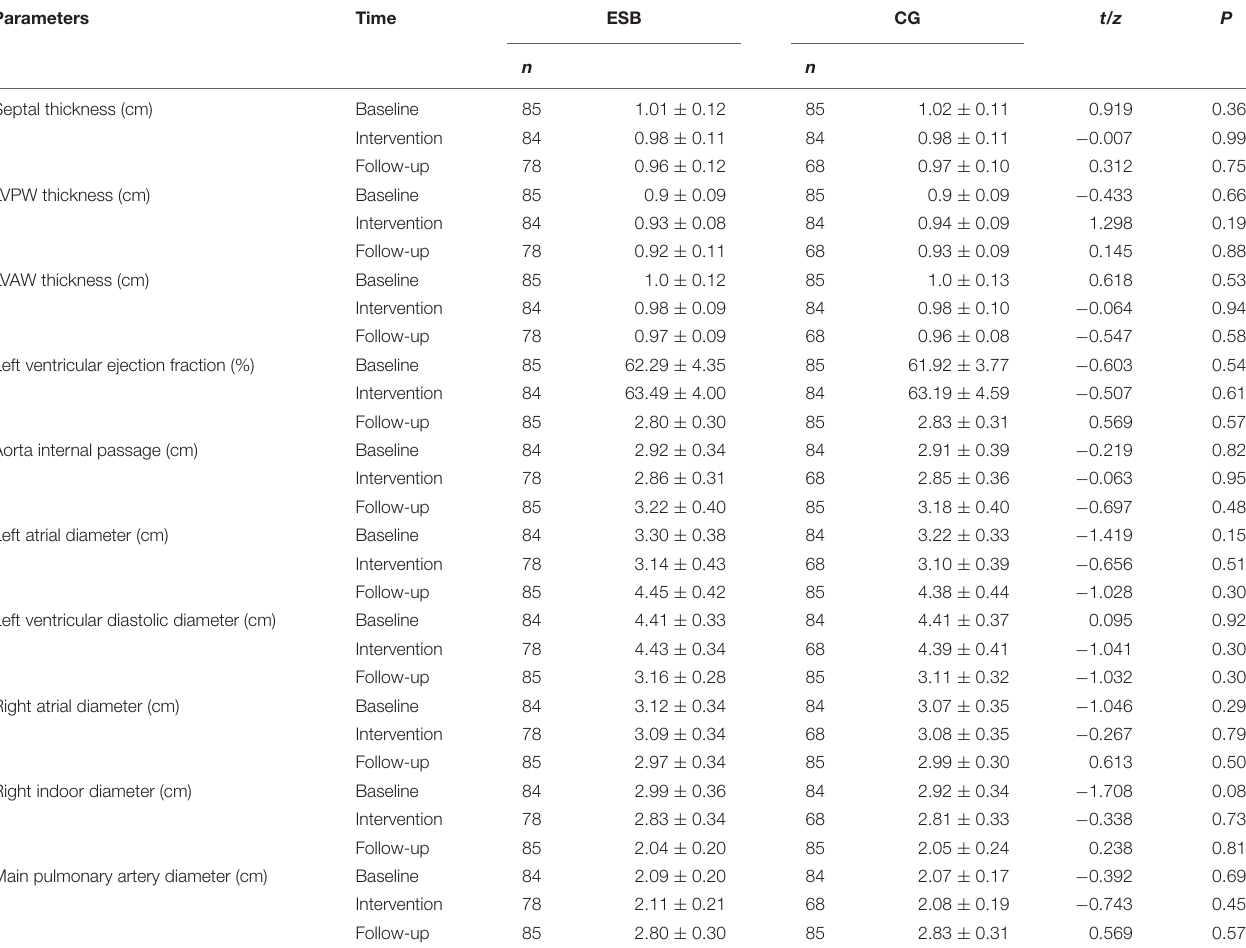
TABLE 2 | Comparison of cardiac structure and left ventricular ejection fraction (%) between two groups.